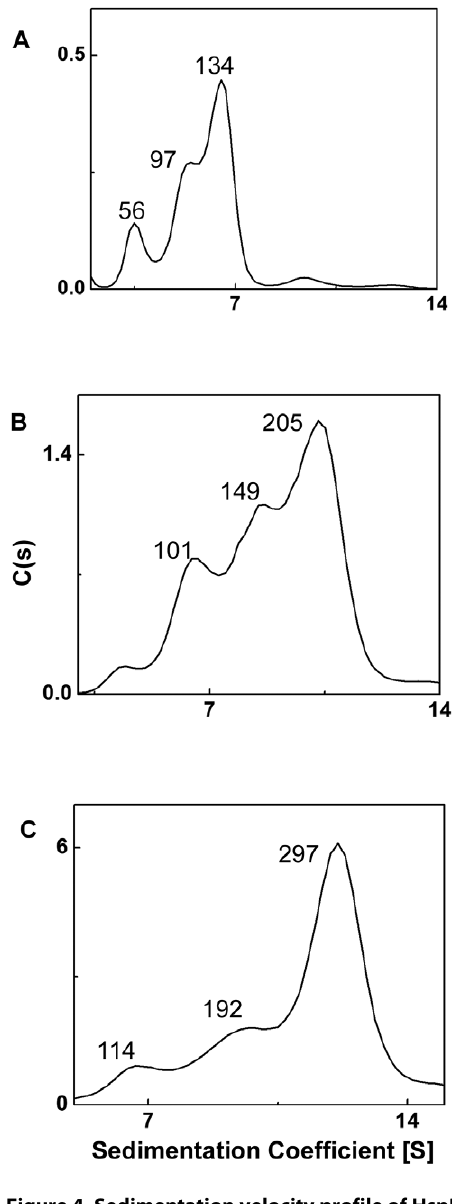
Figure 4. Sedimentation velocity profile of HspB2. Distribution of sedimentation coefficient of different oligomeric species changes with increasing concentration of HspB2. Panels A, B and C correspond to 0.125, 1 and 3 mg/ml of HSPB2. The numbers depicted above the peaks correspond to molecular masses (in kDa) of the oligomeric species.